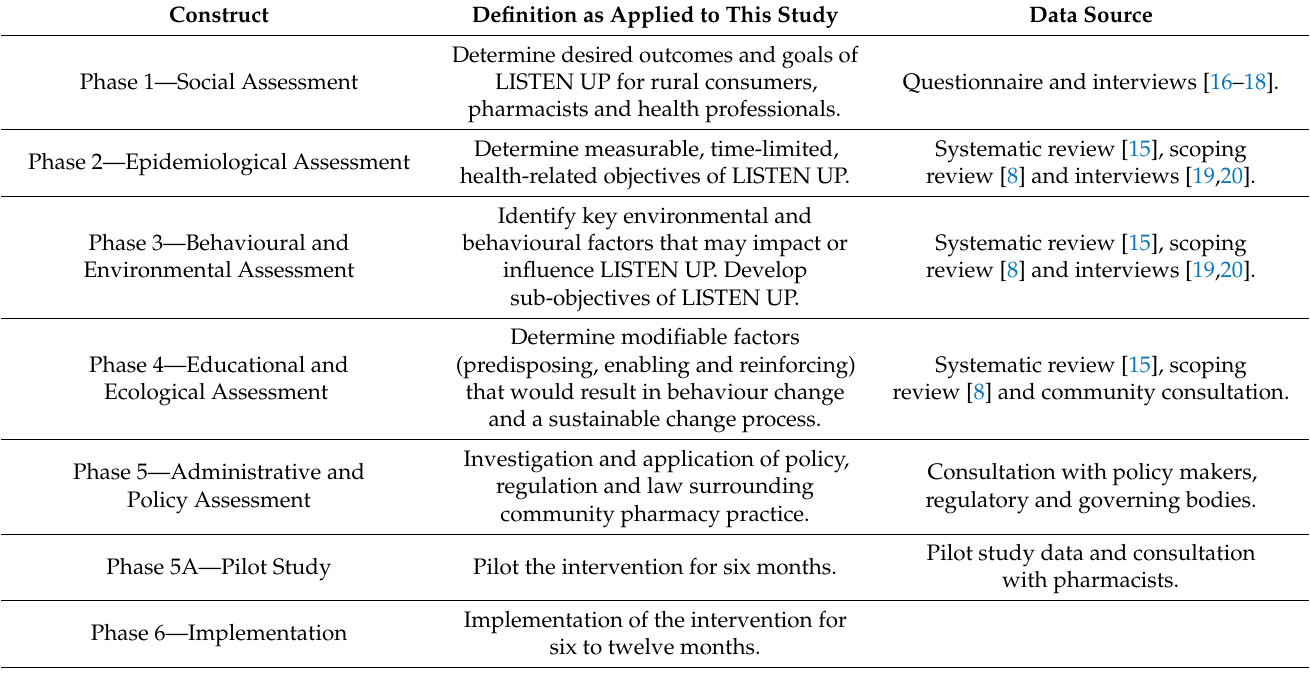
Table 1. Components of the PRECEDE-PROCEED model in the context of LISTEN UP.